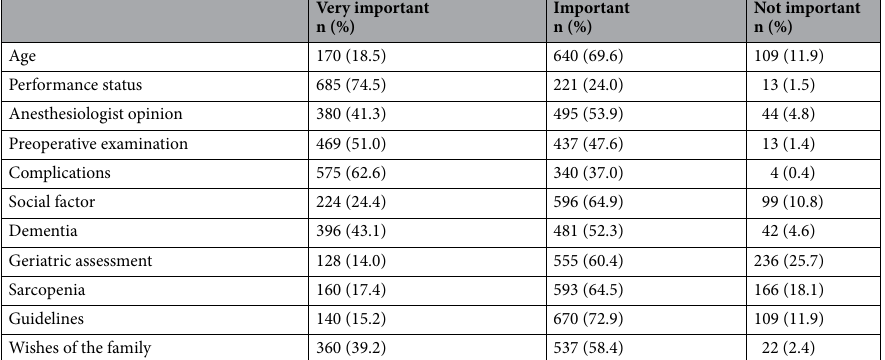
Table 3. Questions and answers on surgical treatment decisions for elderly cancer patients. We asked respondents to, "Please select the importance of each of the following assessment items when deciding surgical treatment methods for elderly cancer patients": (1) age; (2) PS; (3) judgment of anesthesiologist; (4) preoperative examination before treatment; (5) complications; (6) social background such as institutionalization or living alone; (7) presence of dementia; (8) overall evaluation of elderly patients; and (8) overall assessment of the elderly; (9) severity of sarcopenia; (10) guidelines; and (11) wishes of the family. 3: Very important; 2: Important; 1: Not important.